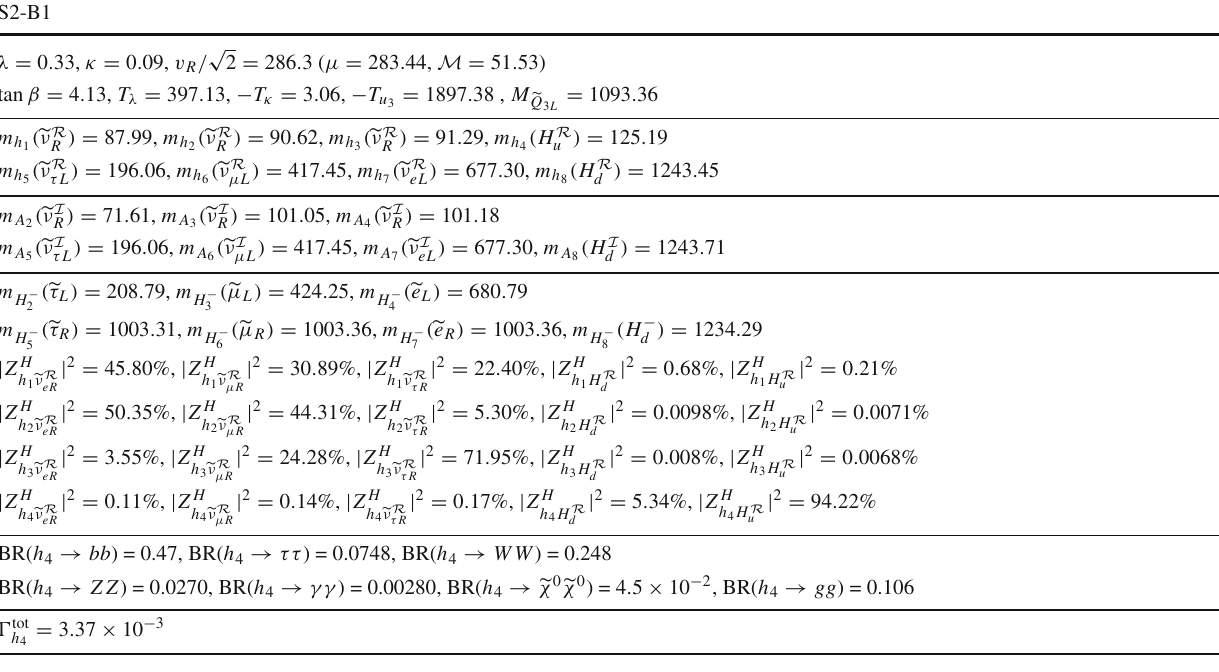
Table 10 The same as in Table 7, but for a benchmark point S2-2h1 with several singlet-like scalars h 2 , 3 , 4 of masses close to the mass of the SM-like Higgs h 1 . Their branching ratios are shown in the sixth-nineth boxes, and their decay widths in the tenth